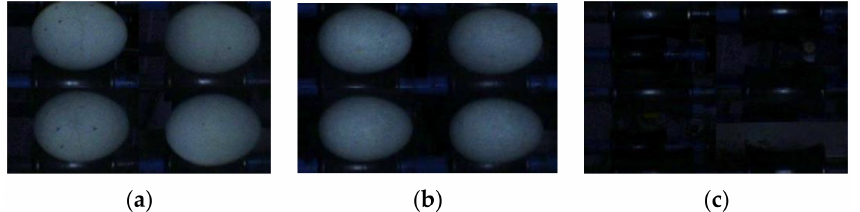
Figure 8. The splicing result of the matrix splicing scheme. ( a ) Cracked preserved egg. ( b ) Preserved egg. ( c )